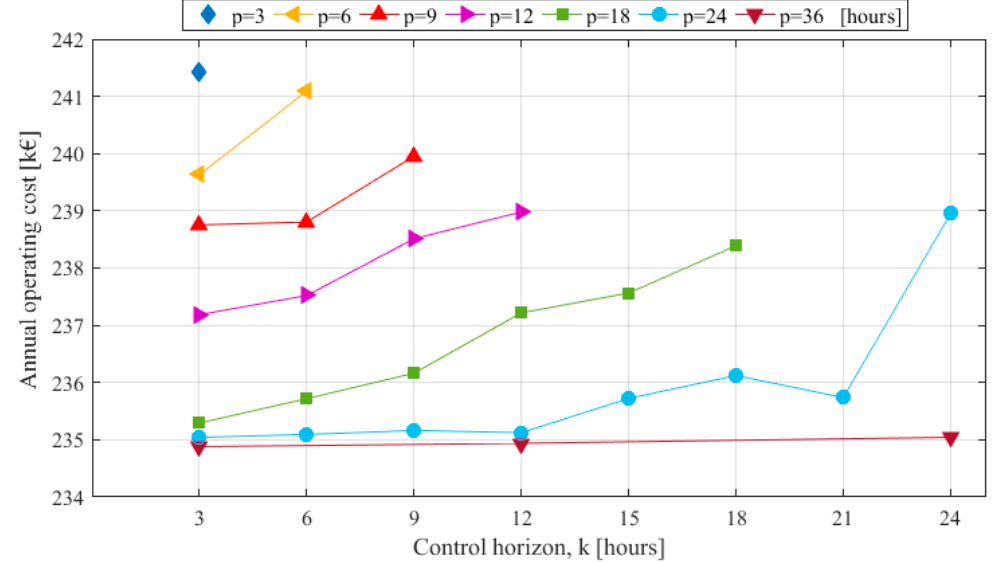
Figure 6. Impact of the prediction and control horizon lengths on the annual operating cost.